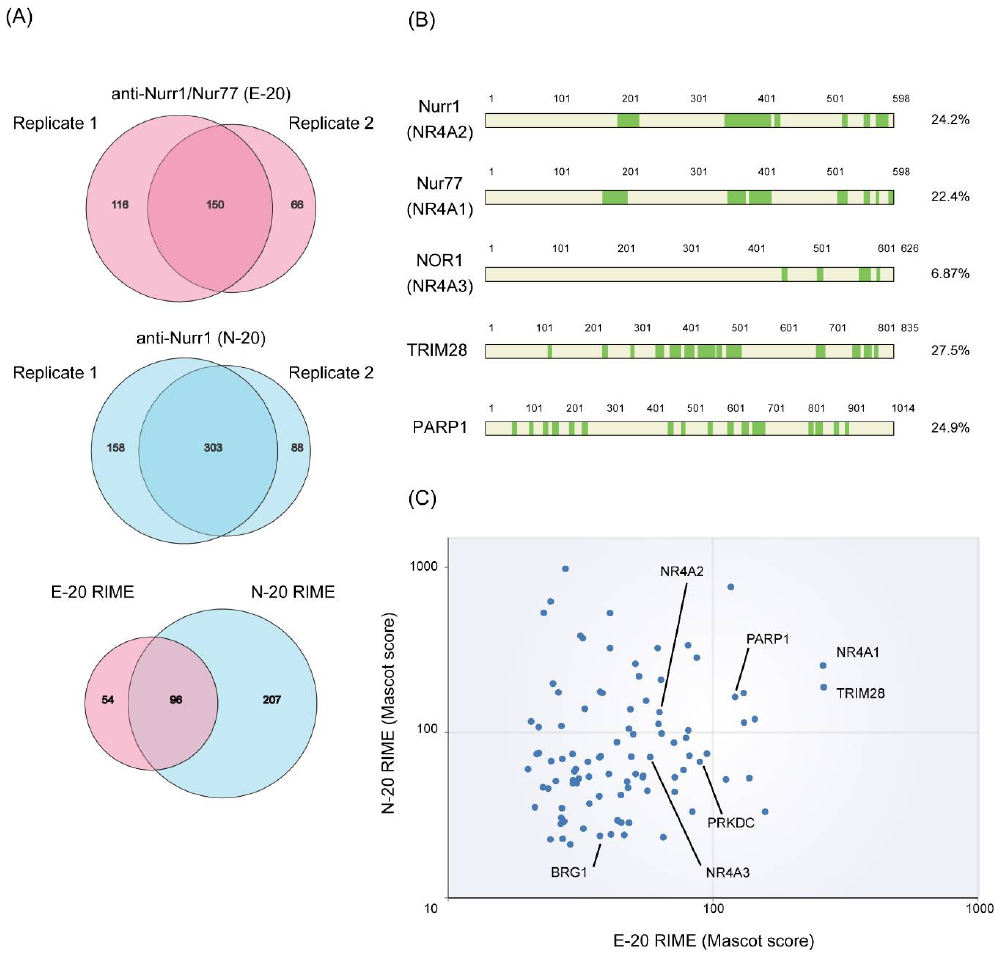
Figure 1. RIME purification of Nurr1-interacting proteins. ( A ) Nurr1 RIME was performed in H295R cells. From two independent RIME purifications using each antibodies indicated, only proteins identified in both experiments were considered and any protein that identified from IgG control was excluded; ( B ) Total peptide coverage of specific identified proteins. Highlighted in green indicates peptides identified with high confidence (False discovery rate (FDR) < 0.01); ( C ) Two replicates of RIME purification using two different antibodies were conducted and proteins identified in all replicates were plotted. The axis represents log 10 scale of Mascot score for each RIME (replicate 2).